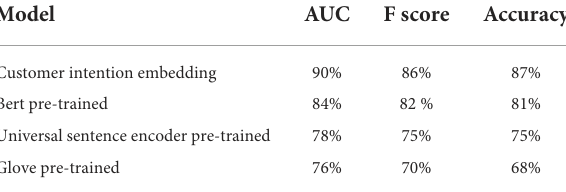
TABLE 1 Search engine marketing (SEM) ads vs. ad groups: Data-set overview.